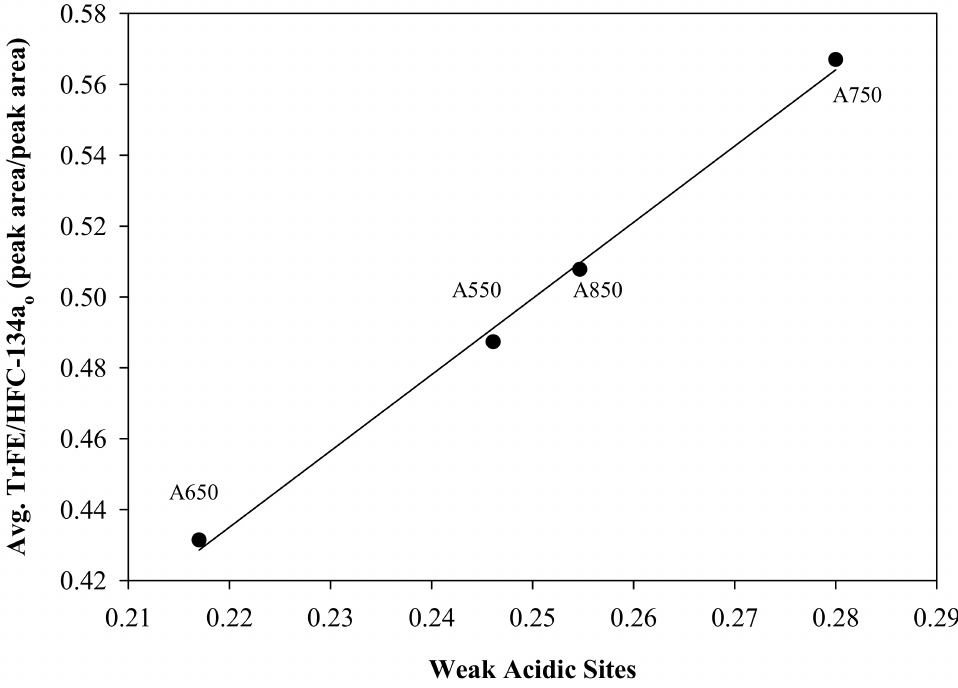
Figure 6. Linear relationship between TrFE formation and weak acidic sites.